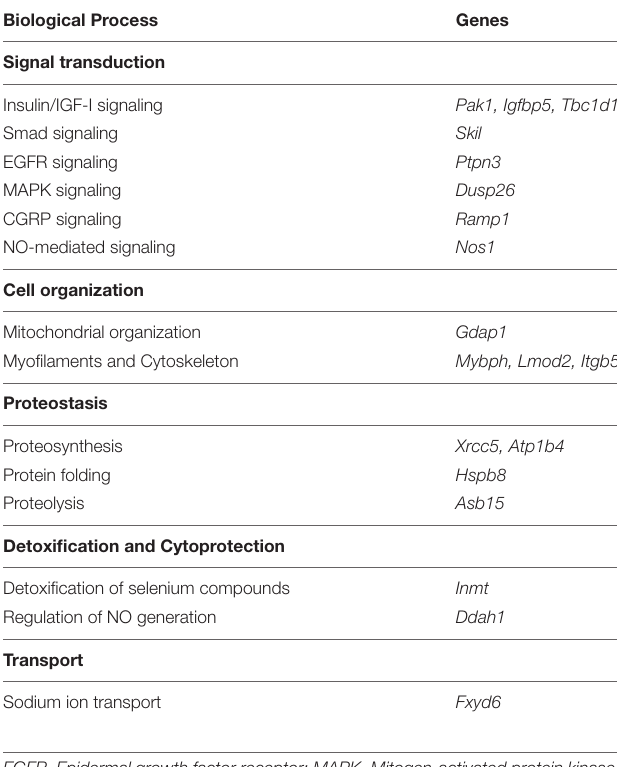
TABLE 3 | Biological processes regulated by the commonly regulated genes following MSTN